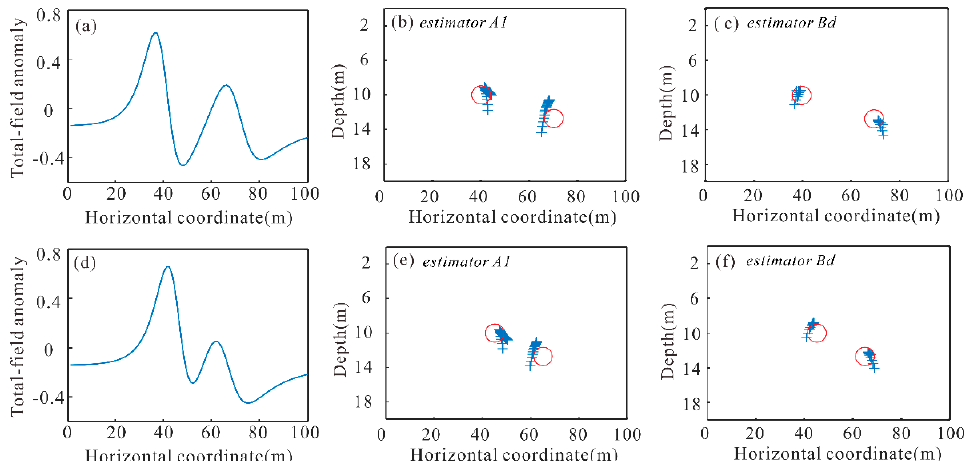
Figure 3. ( a ) Total magnetic anomaly of two cylinders with horizontal coordinates ( x 0 ) of 40 m and 70 m; ( b ) source location results generated by estimator A1, using the magnetic anomaly in Figure 3a; ( c ) source location results generated by estimator Bd, using the magnetic anomaly in Figure 3a; ( d ) total magnetic anomaly of two cylinders with horizontal coordinates ( x 0 ) of 45 m and 65 m; ( e ) source location results generated by estimator A1, using the magnetic anomaly in Figure 3d; ( f ) source location results generated by estimator Bd, using the magnetic anomaly in Figure